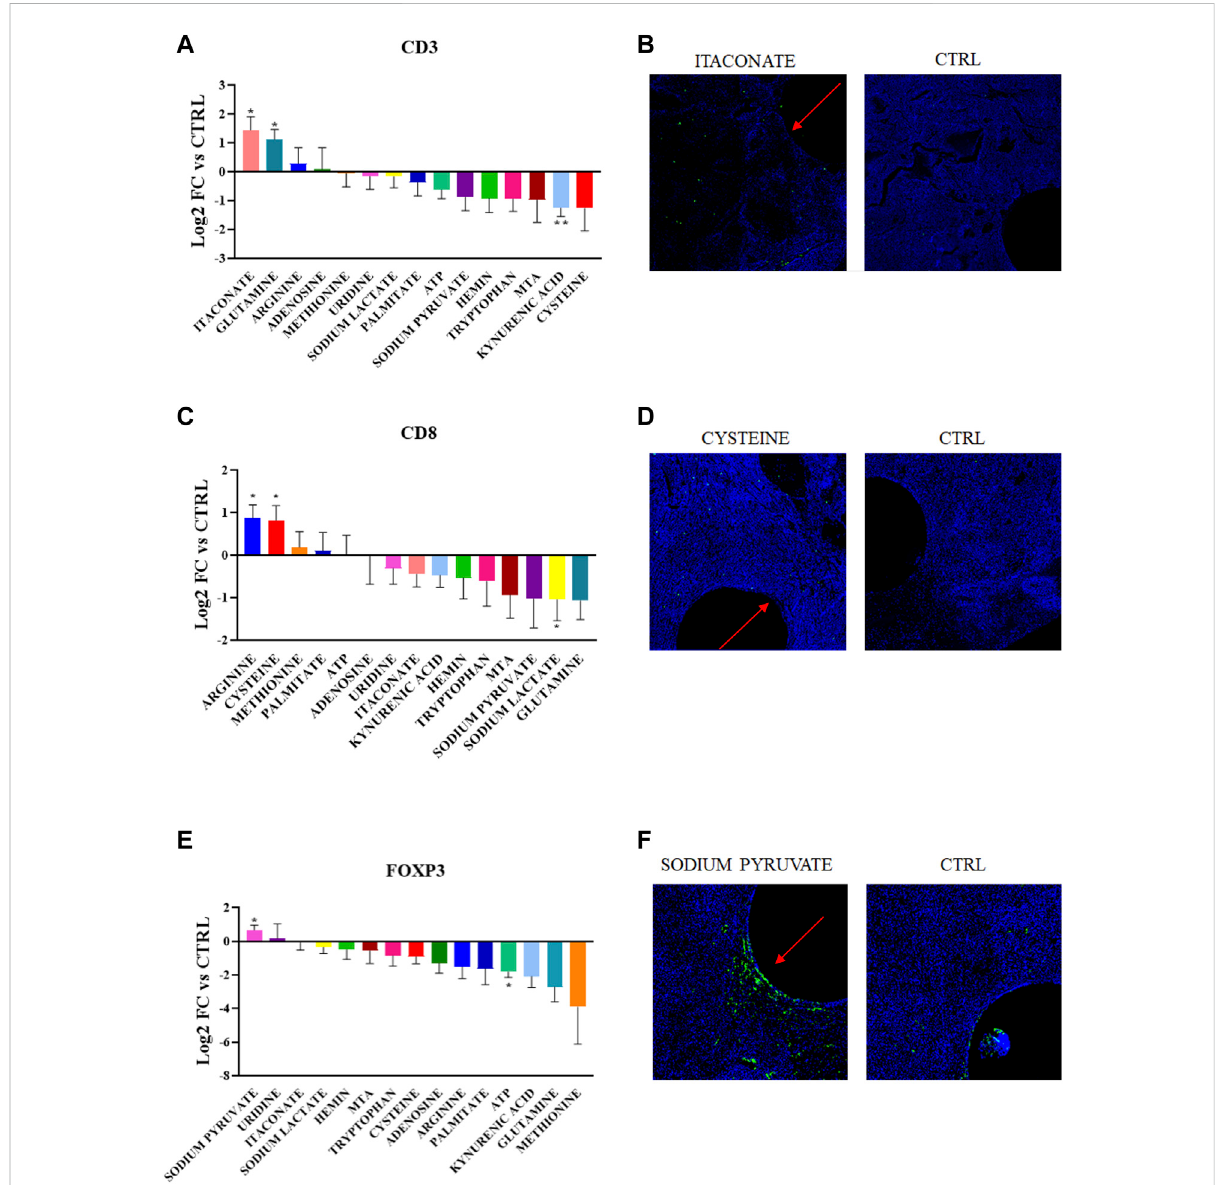
FIGURE 2 (A,C,E) Quanti fi cation ofCD3 + , CD8 + and FOXP3+ abundanceinthecorresponding region ofeach metabolic perturbation. Valuesare theLog of the fold change normalizing the number of positive cells detected in the ROI vs. positive cells in the control region of the same tumor. p -values indicatecomparisonbetweensignalintensitiesateachdrugsitecomparedtoControl(* p < 0.05,** p < 0.005) (B,D,F) Representativeimagesshowing the IF/IHC staining on the tumor